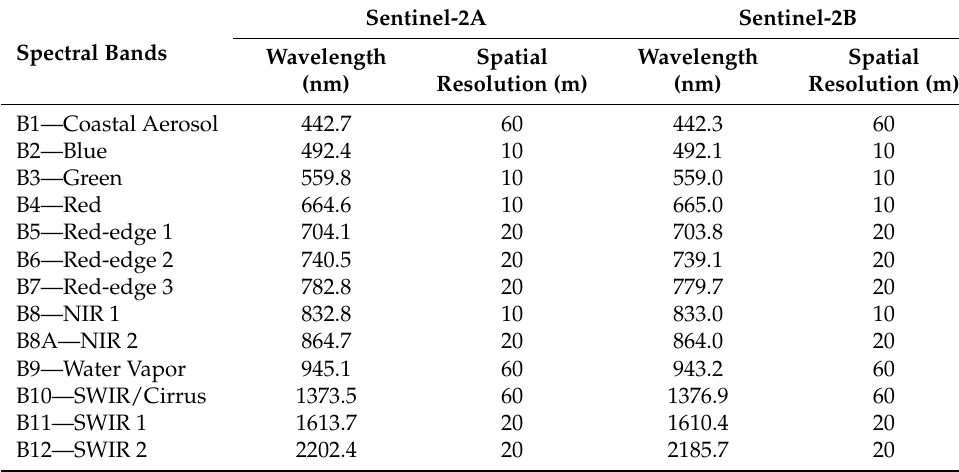
Table 1. Spectral characteristics of Sentinel-2